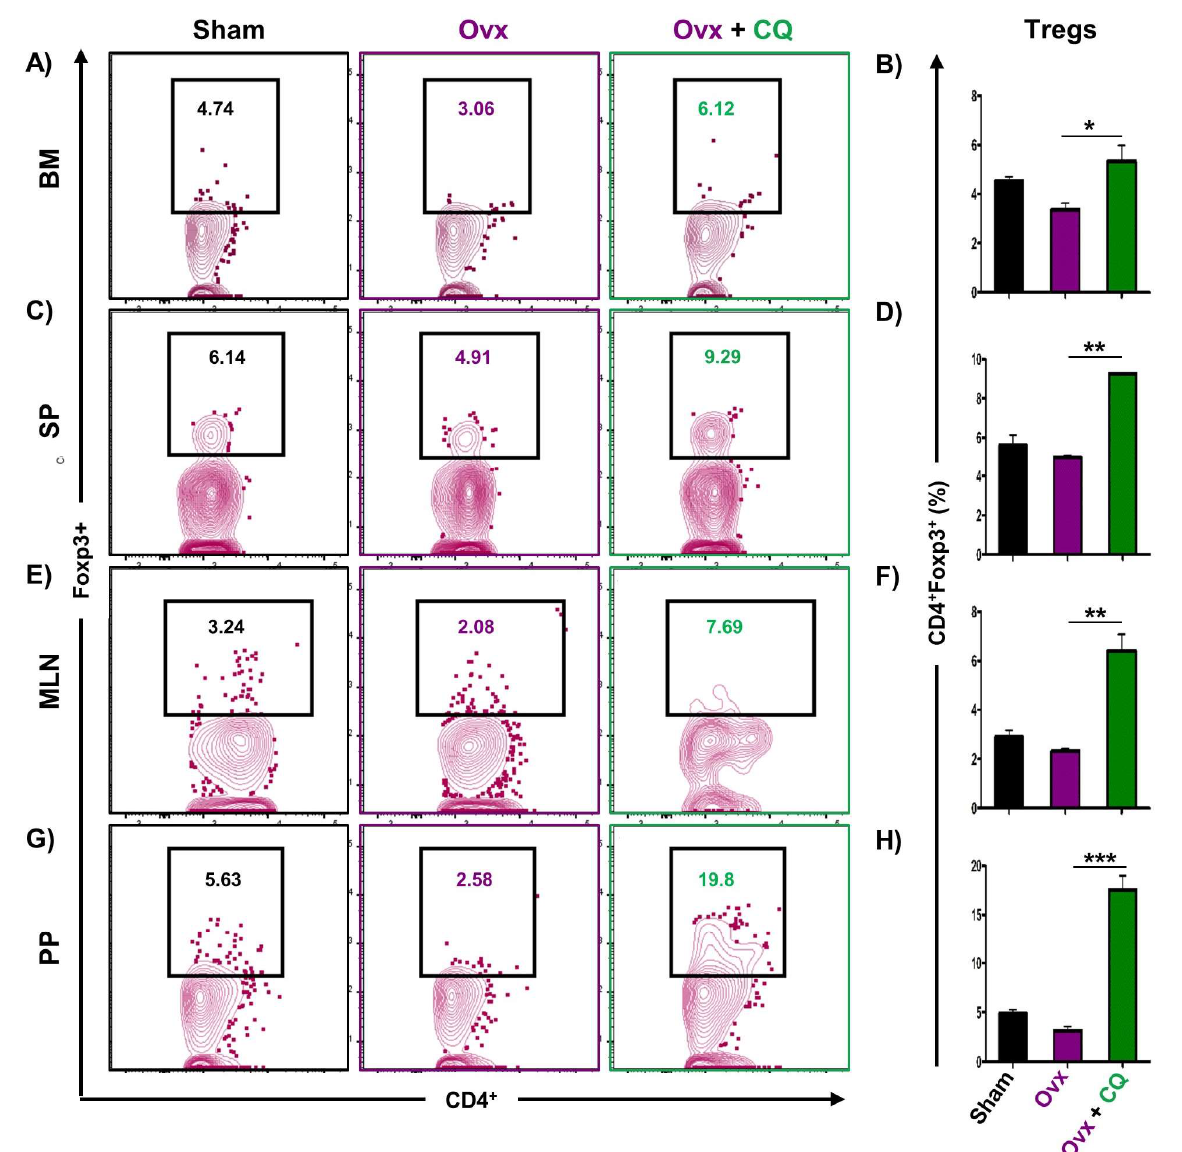
Figure 7. CQ administration enhances Tregs cells in Ovx mice : Immune cells harvested from the lymphoid organs of all the groups were analyzed by flow cytometry for the percentage of CD4 + Foxp3 + Treg immune cells. ( A ) Contour plot representing the percentage of CD4 + Foxp3 + Treg in BM. ( B ) Bar graphs representing the percentage of CD4 + Foxp3 + Treg in BM. ( C ) Contour plot representing the percentage of CD4 + Foxp3 + Treg in SP. ( D ) Bar graphs representing the percentage of CD4 + Foxp3 + Treg in SP. ( E ) Contour plot representing the percentage of CD4 + Foxp3 + Treg in MLN. ( F ) Bar graphs representing the percentage of CD4 + Foxp3 + Treg in MLN. ( G ) Contour plot representing the percentage of CD4 + Foxp3 + Treg in PP. ( H ) Bar graphs representing the percentage of CD4 + Foxp3 + Treg in PP. ANOVA was used to analyse the results, and then unpaired Student t -tests were used to compare the indicated groups. Values are expressed as mean ± SEM, and equivalent outcomes were observed in two independent experiments. For the indicated groups, p 0.05 (* p ≤ 0.05, ** p ≤ 0.01, *** p ≤ 0.001) was used as the cutoff for statistical significance.